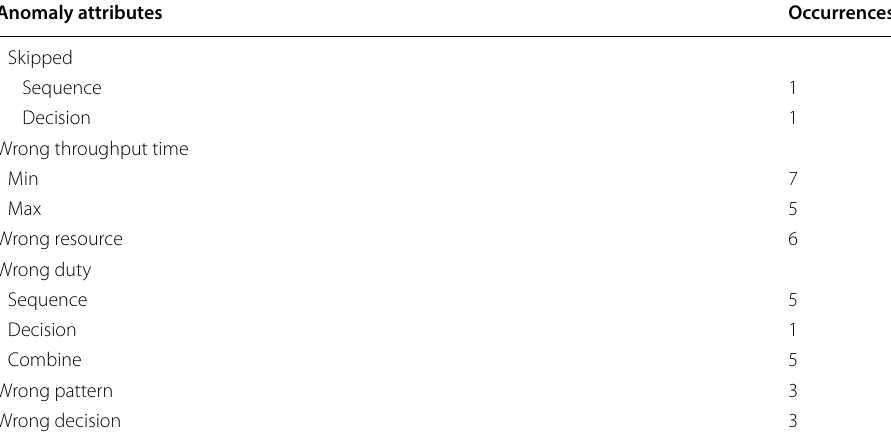
Table 11 The occurrences of anomaly attributes generated by a Poisson distribution